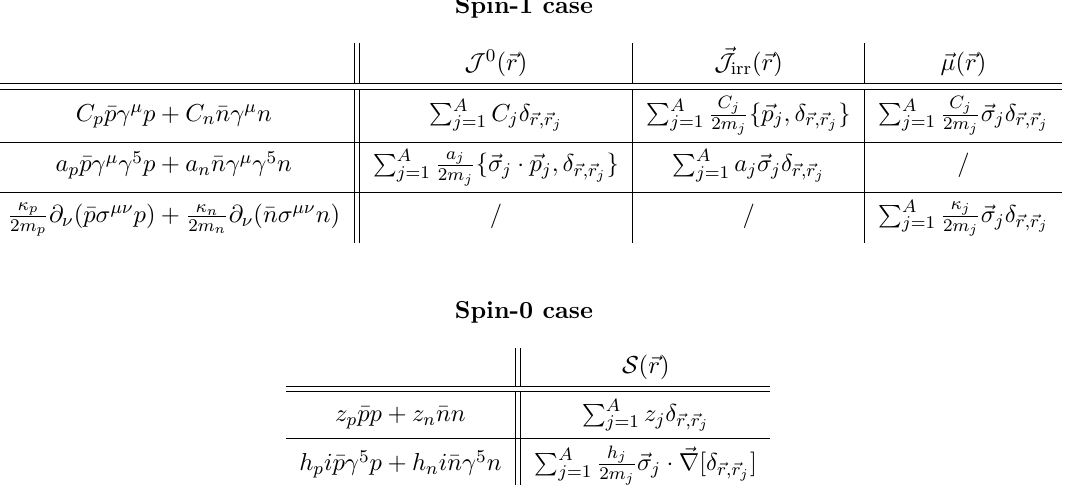
Table 3 . Leading term of the non relativistic expansion for the relativistic vector current, the relativistic axial current and the anomalous magnetic moment terms (upper table) and for the scalar and pseudoscalar density (lower table). δ